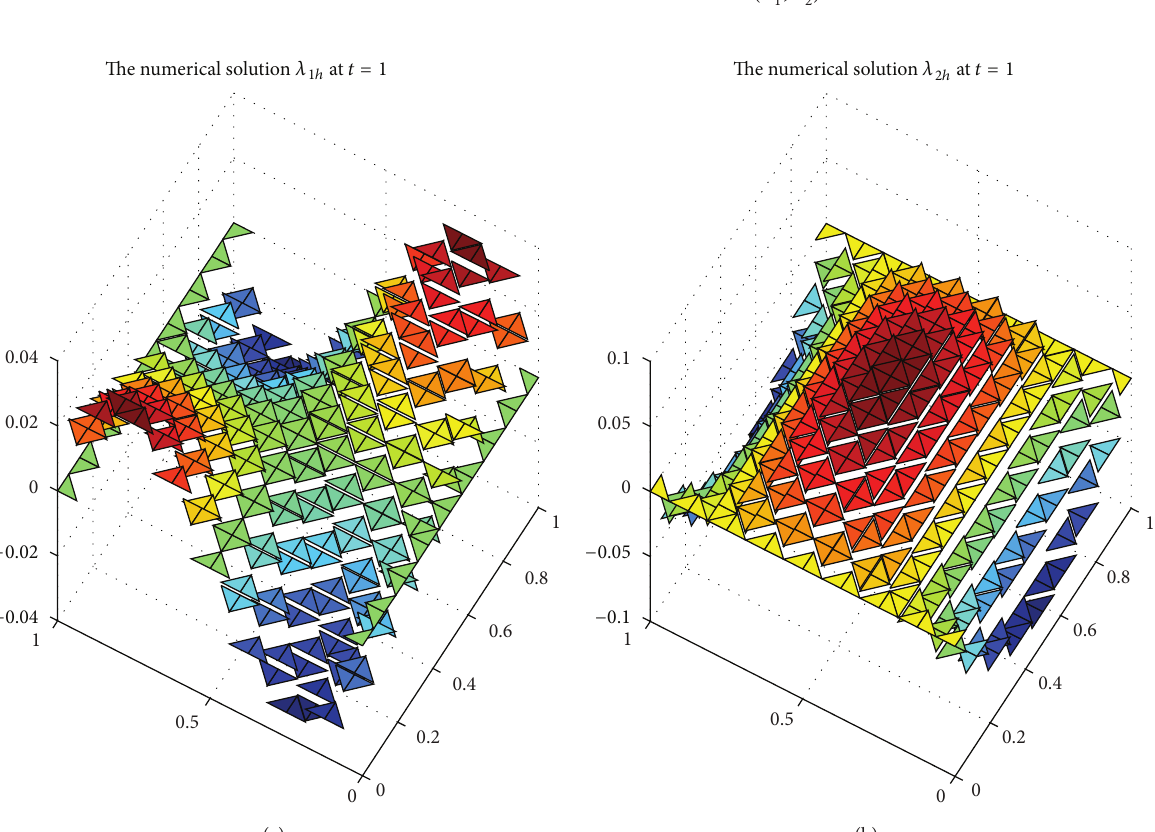
Figure 4: The surface for the numerical solution 𝜆 ℎ = (𝜆 1ℎ , 𝜆 2ℎ )